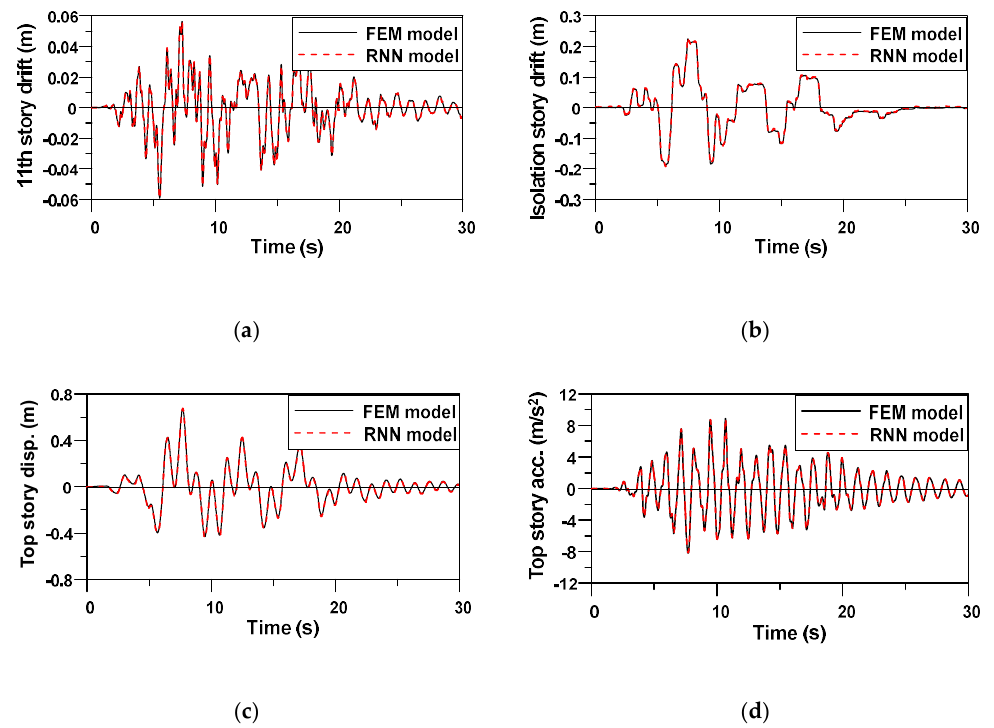
Figure 11. Comparison of the time history responses of Example 2 between FEM and RNN models (EQ No. 11): ( a ) 11 th story drift time history; ( b ) Isolation story drift time history; ( c ) Top story displacement time history; ( d ) Top story acceleration time history.